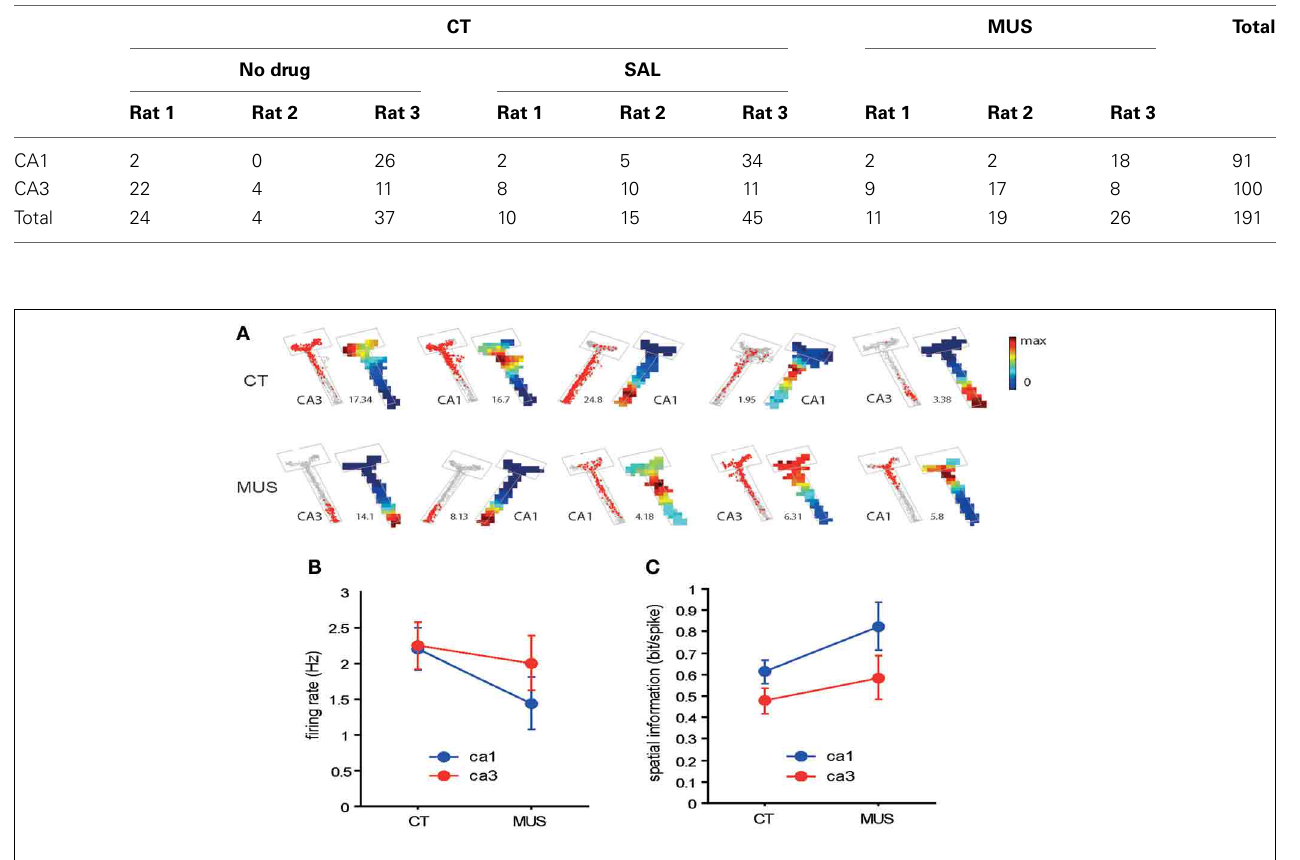
FIGURE 4 | Overall spatial firing of CA1 and CA3 neurons. (A) Examples of spatial firing patterns of individual neurons from CA1 and CA3 in different drug conditions. For each neuron, a raw spiking map (gray dot = position trace) is presented on the left and the associated firing rate map is shown on the right. The number between the two indicates maximal firing rate (Hz). The boundary of the arm is also shown in gray lines. Firing rates are color-scaled